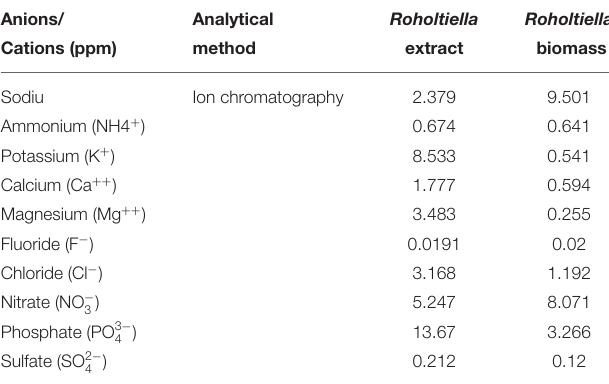
TABLE 2 | Chemical content of cyanobacteria extract and